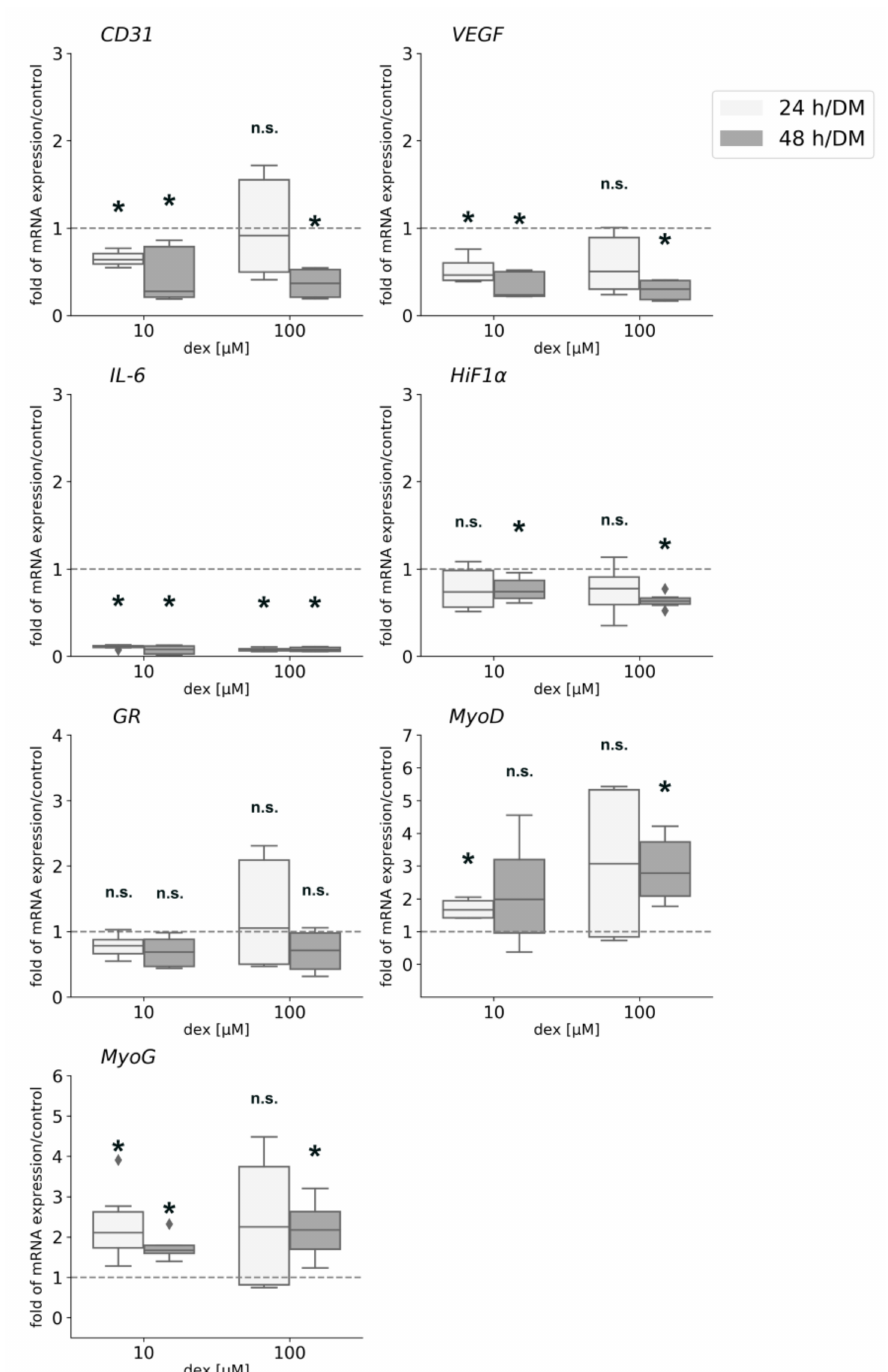
Figure 10. Gene expression analyses for CD31 , VEGF , IL-6 , HiF1 α , GR , MyoD , and MyoG in the co-culture after 24 and 48 h in DM with or without 10 or 100 µ M dex. The mRNA levels were normalized to GAPDH and calculated as ratios in relation to the untreated control group (interrupted line). Results are presented as medians and quartiles ( n = 3), and p values < 0.05 indicate statistical significance (* p < 0.05), n.s. = non-significant. Outliners are presented as